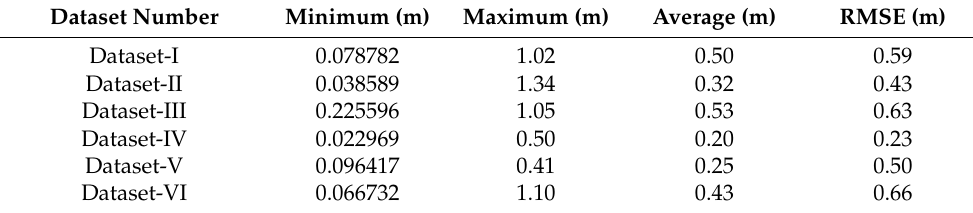
Table 3. Location deviation of telegraph poles for the six datasets.